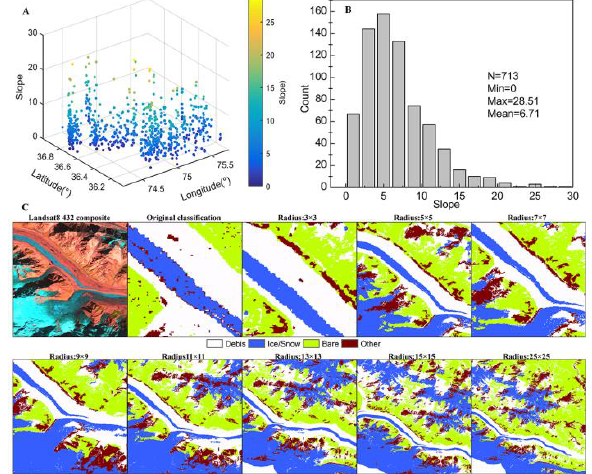
Figure 2. Post-classification processing: A) 3D distribution of slope in the debris-covered area of glaciers; B) histogram of slope statistics; C ) comparison of removal effects under different kernel radius and kernel types, 5×5 square type, and 50 connected pixels were